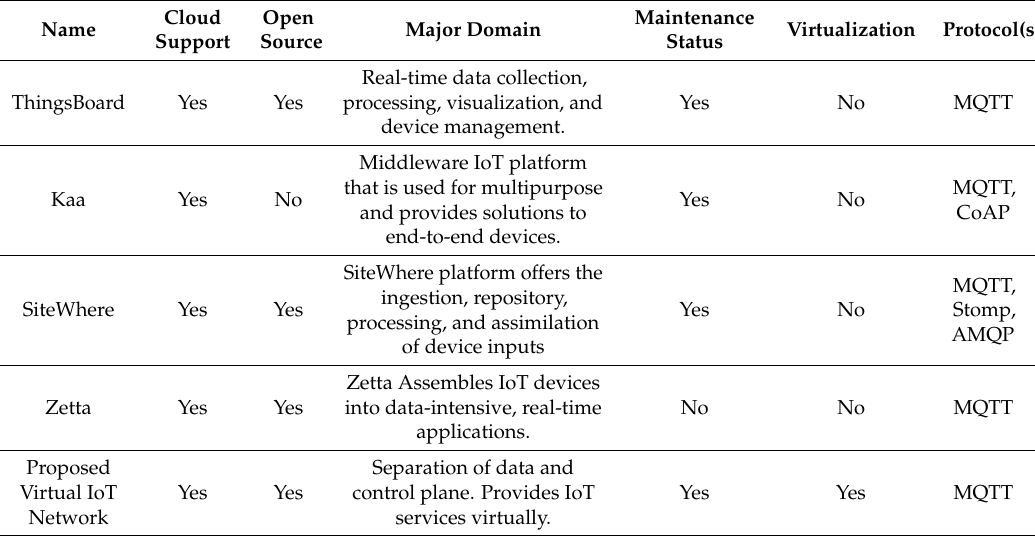
Table 5. Comparative analysis of proposed network with existing state-of-the-art